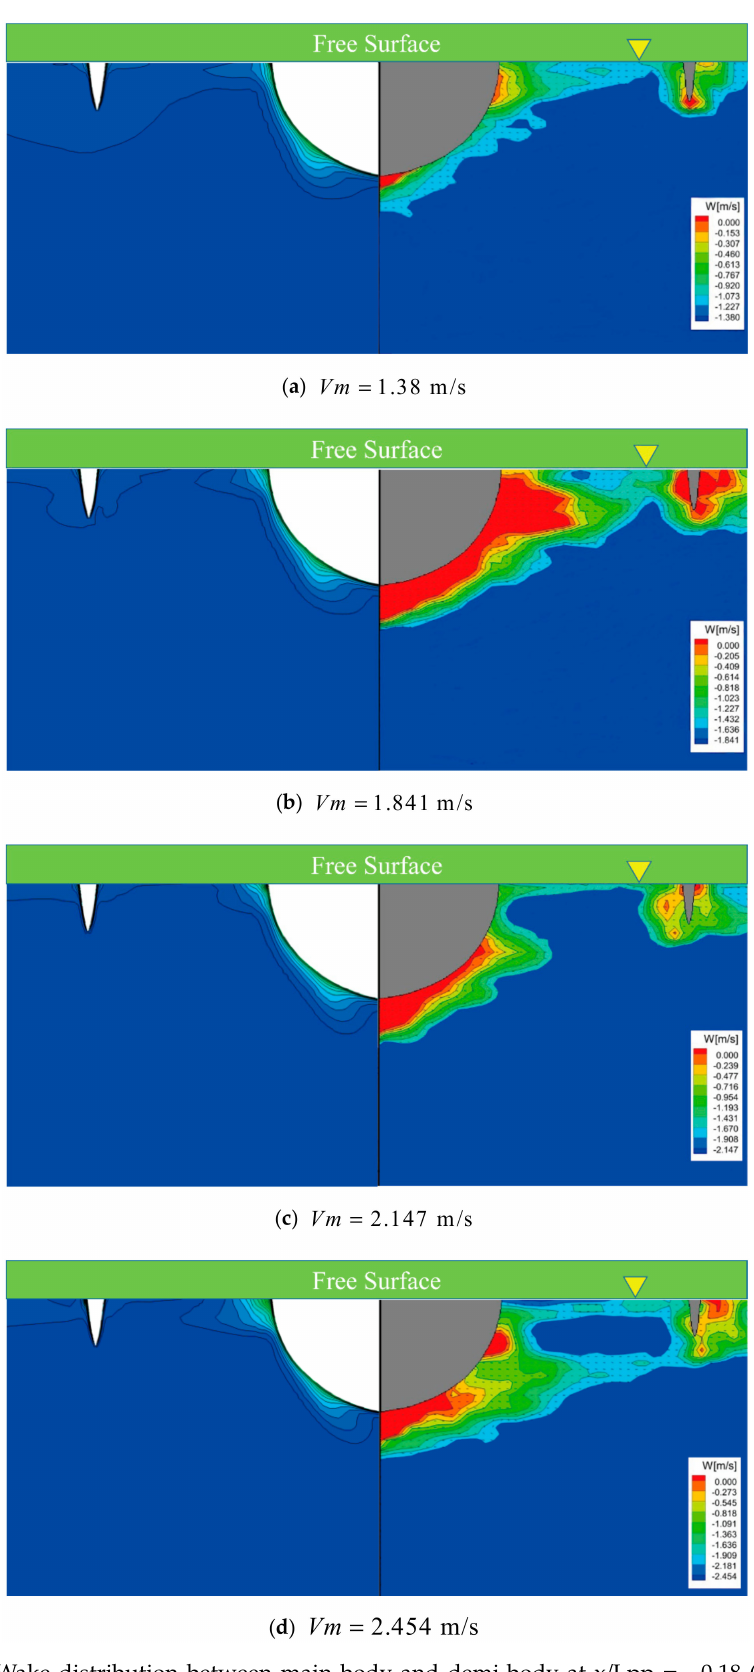
Figure 16. Wake distribution between main body and demi-body at x / Lpp = − 0.18 (( left ): CFD, ( right ):